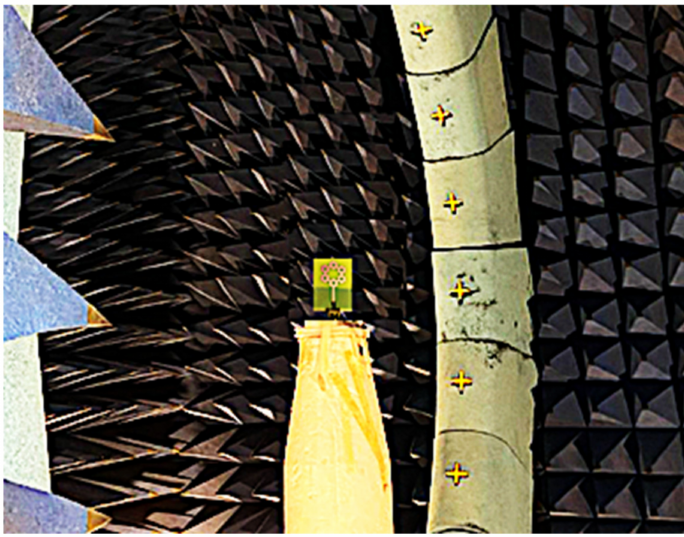
Figure 12. Measurement setup for radiation properties.